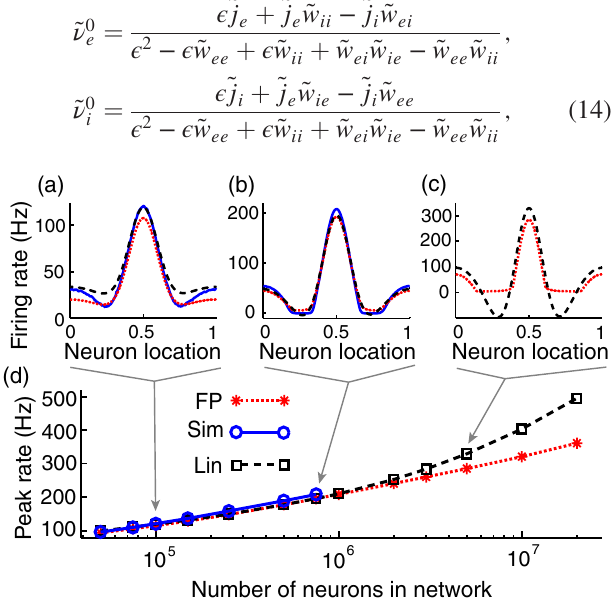
FIG. 4. Loss of balanced state when external inputs are narrower than recurrent connections. Firing rates of the excitatory population when external inputs are narrower than recurrent inputs for system sizes (a) N ¼ 10 5 , (b) N ¼ 7 . 5 × 10 5 , and (c) N ¼ 5 × 10 6 . (d) Peak firing rate of the excitatory population as a function of system size. In all panels, σ σ σ 0 . 2 , and other parameters are as in Fig. 3. Dotted e ¼ i ¼ red curves computed by numerically solving Eq. (12). Solid blue curves computed from full network simulations. Dashed black line computed from the linear approximation given in Eq. (14).